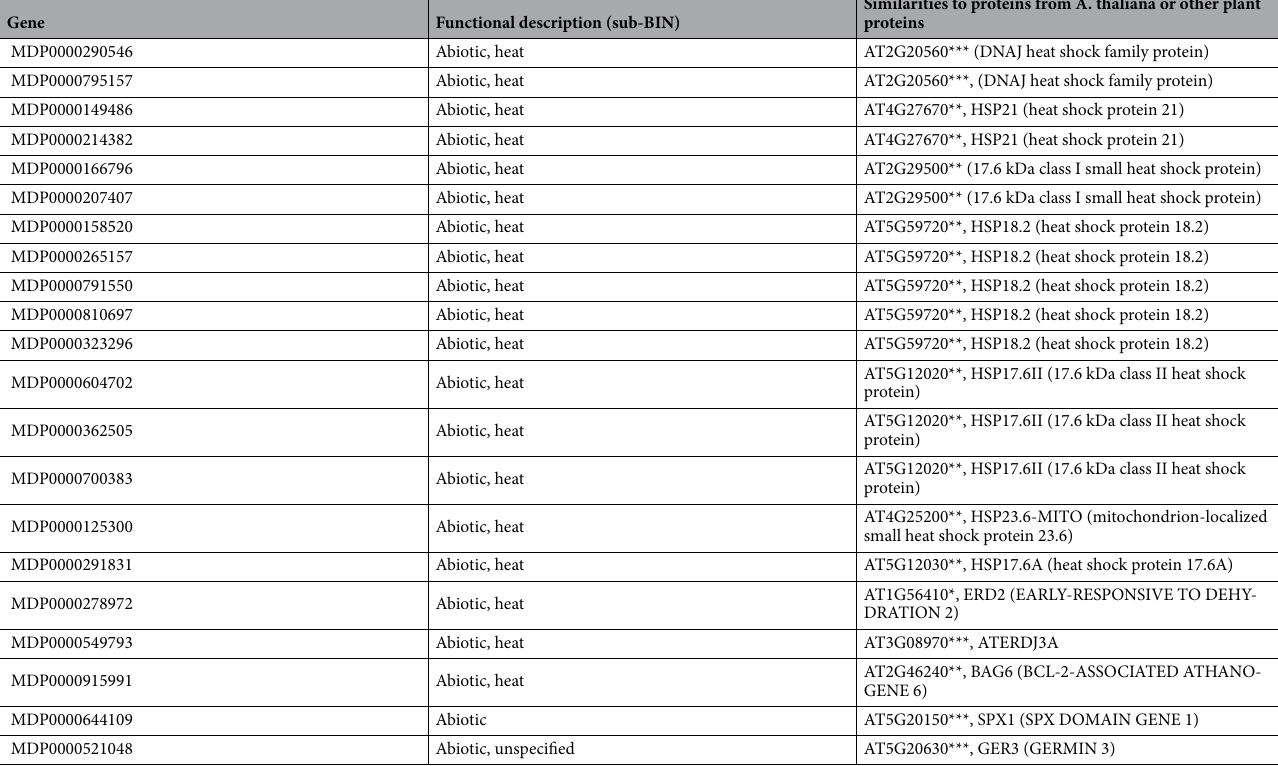
Table 2. DEGs categorized to functional groups ‘RNA’, ‘stress’ and ‘secondary metabolism’. All identified differential expressed genes categorized by MapMan to the BINs ‘RNA’, ‘stress’ and ‘secondary metabolism’ are displayed and filtered after their differential expression level, either during resistant reaction (after inoculation with wild type strain Ea1189) or susceptible reaction (after avrRpt2 EA deletion mutant strain ZYRKD3-1). The functional description of the sub-BIN and the degree of similarity to proteins from A. thaliana is given. (*) very weakly similar, (**) weakly similar, (***) moderately similar, (****) highly similar, (*****) nearly identical to protein from Arabidopsis thaliana ; TF (transcription factor); 1 moderately similar to Thaumatin-like